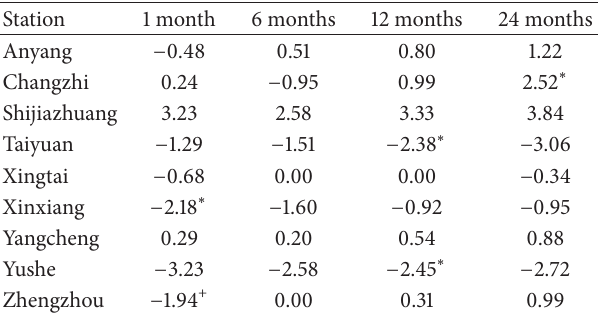
Table 1: Slope values of SPEI (YR − 1 ) for the study stations at 1, 6, 12, and 24 months’